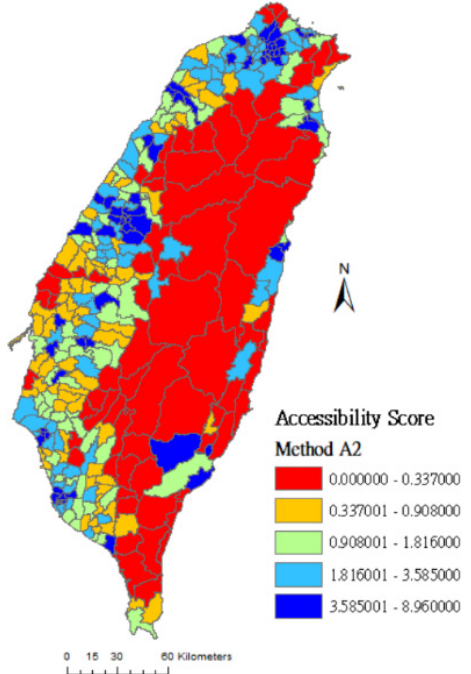
Figure 4. Accessibility score of rehabilitation physician service in Taiwan using method A2.